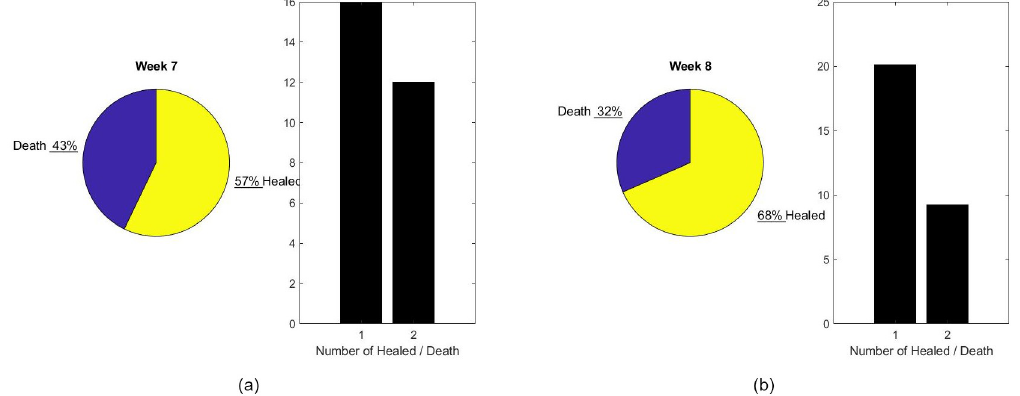
Fig 12. Prediction of performance in Scenario 1. (a) Patient output for previous week (b) Patient output predicted for next week.